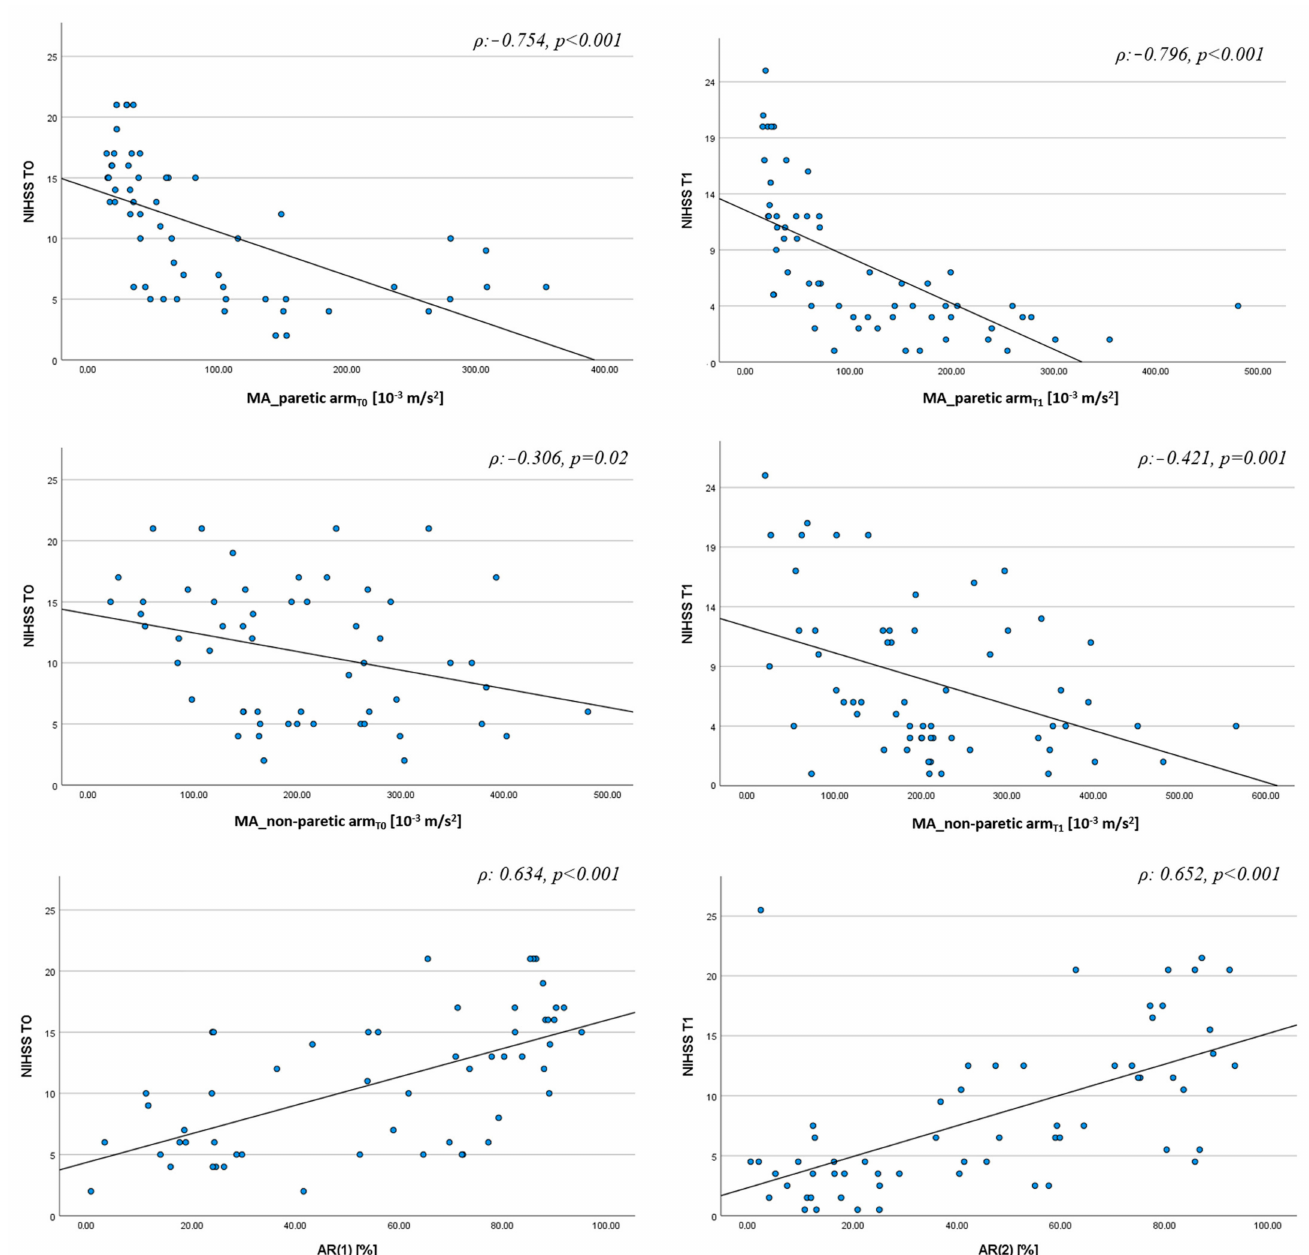
Figure 4. Correlation analysis between actigraphic indices and NIHSS scores at T0 and T1. NIHSS = National Institutes of Health Stroke Scale, AR = Asymmetry Index, MA = Motor Activity